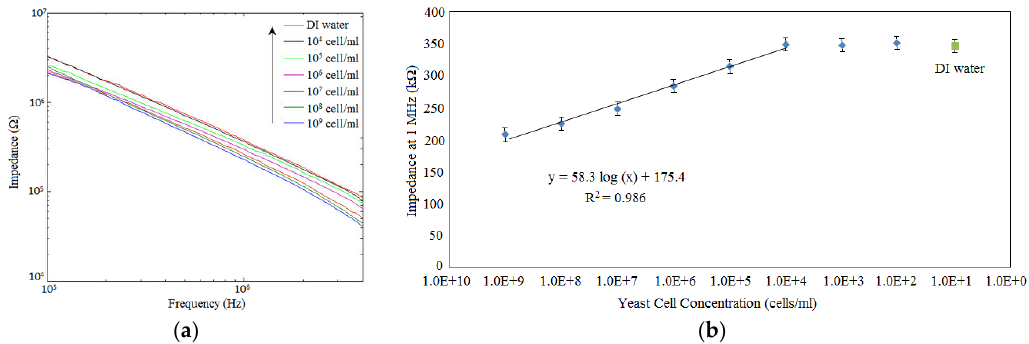
Figure 6. ( a ) Impedance spectra of yeast cells in water with cell concentrations ranging from 10 2 to 10 9 cfu/mL, along with DI water as control; ( b ) The linear relationship between the logarithmic value of the concentration of yeast cells and the impedance measured at 1 MHz. Error bars are standard deviations of 5 measurements.